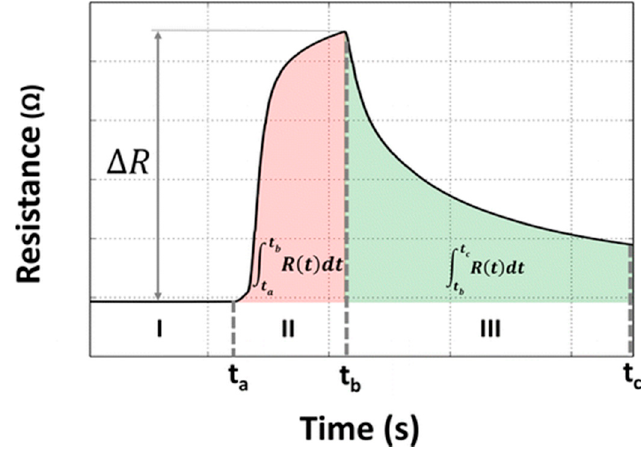
Figure 2. A typical electrical response from a gas sensor [24].